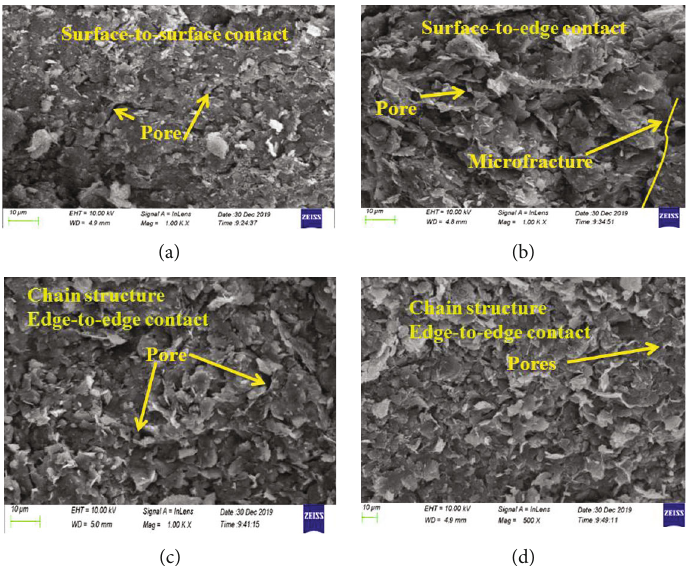
Figure 8: SEM image at a magni fi cation of 1000: (a) no D-W cycles; (b) one D-W cycles; (c) three D-W cycles; (d) fi ve D-W cycles.